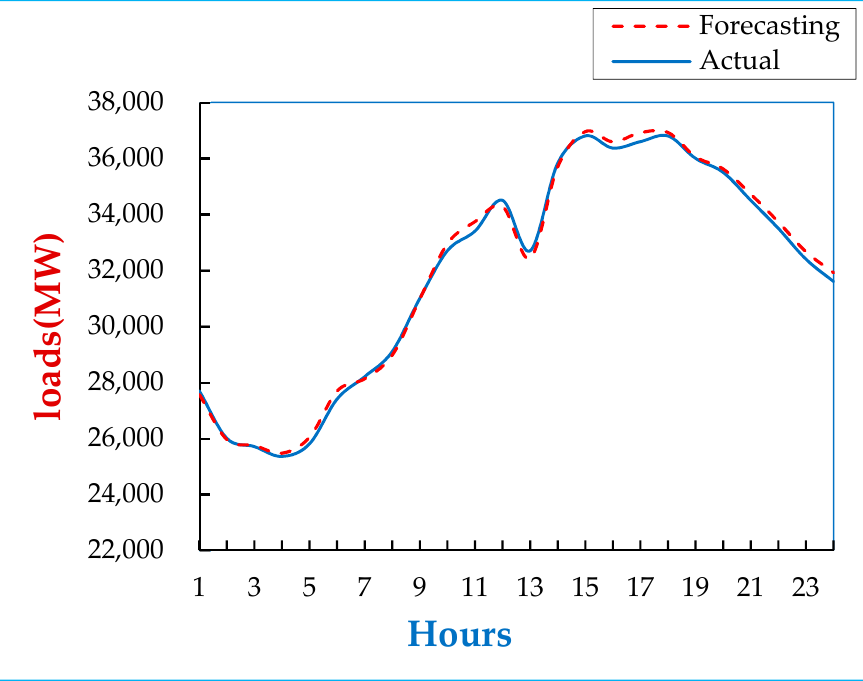
Figure 5. Load forecasting results for working days (Wednesday, 16 September 2020).